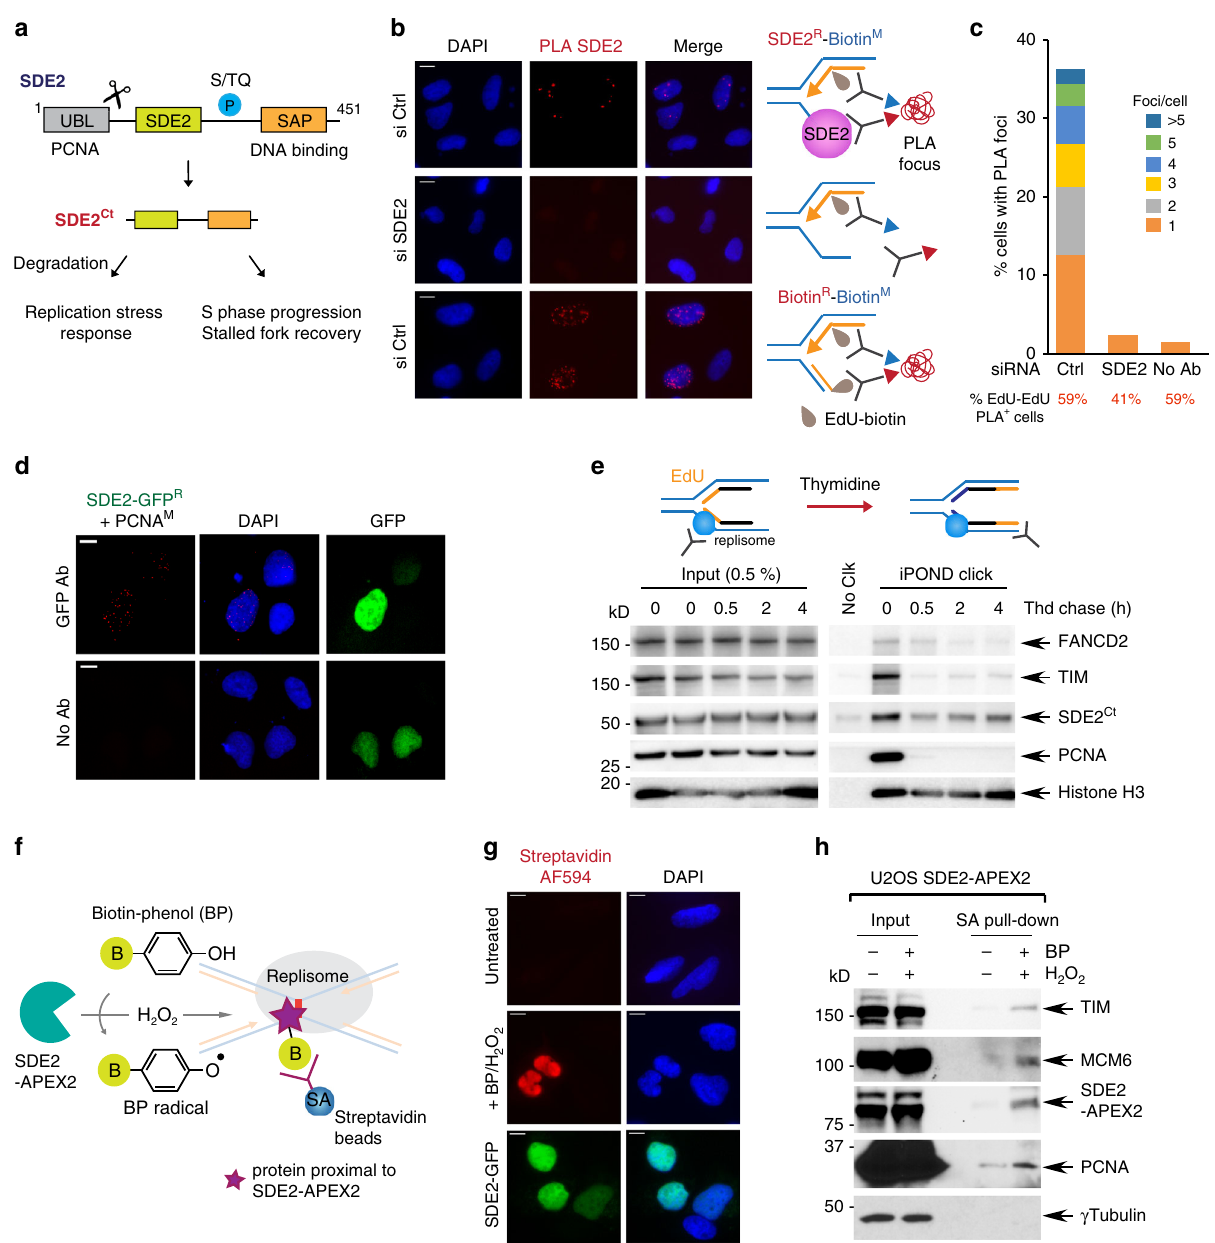
Fig. 1 SDE2 is localized at replication forks. a Human SDE2 domain structures and roles of the processed SDE2 Ct in the replication stress response and replication fork integrity. b Representative images of SDE2:EdU-biotin PLA foci with schematic of the PLA design. The biotin:biotin PLA was used as a positive control to mark replicating cells. M: mouse, R: rabbit, primary antibodies used. Scale bar, 10 μ m. c Quanti fi cation of cells positive for SDE2:EdU PLA foci and the number of foci per nuclei. A representative graph from two independent experiments is shown. More than 150 cells were scored per experimental condition. d PLA between SDE2-GFP and endogenous PCNA. Scale bar, 10 μ m. e Western blot (WB) analysis of iPOND samples from EdU pulse and thymidine chase to reveal the proteins speci fi cally associated with the replisome. f Schematic of the SDE2-APEX2 in situ proximity biotinylation to tag proteins proximal to SDE2. g Fluorescence imaging of SDE2-APEX2 labeling of nuclear proteins, detected by streptavidin-conjugated Alexa Fluor (AF) 594. Nuclear localization of SDE2-GFP was con fi rmed by GFP fl uorescence. Scale bar, 10 μ m. h WB analysis of biotinylated proteins by proximity labeling. U2OS cells stably expressing SDE2-APEX2 were incubated with BP and H 2 O 2 , and biotinylated proteins were enriched by streptavidin